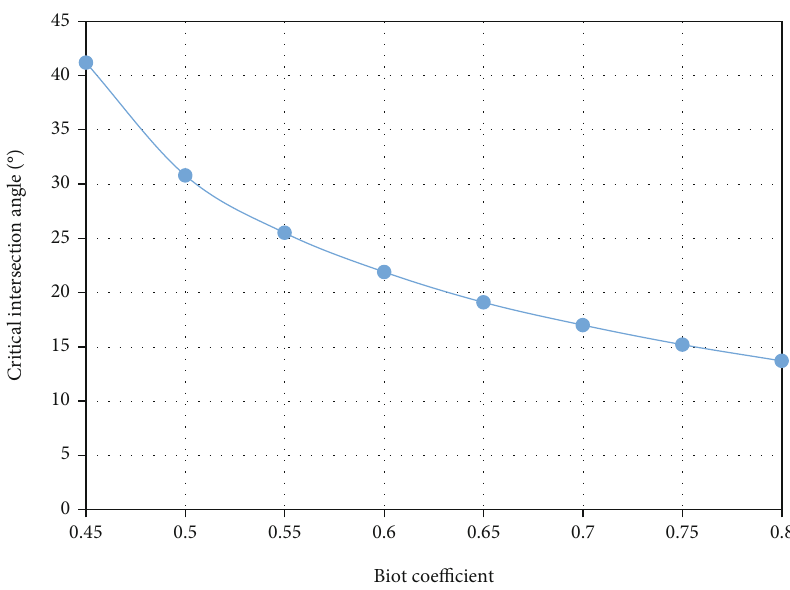
Figure 19: Critical intersection angle with di ff erent Biot coe ffi cient.